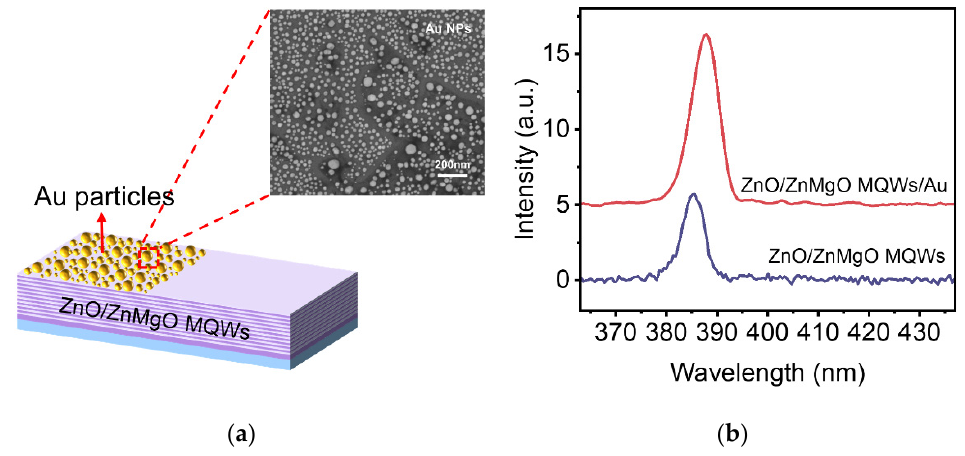
Figure 5. The Schematic and MPA upconversion PL spectra of ZnO/ZnMgO MQWs/Au NPs. ( a ) Schematic of ZnO/ZnMgO MQWs/Au NPs composite. Inset, the SEM image of Au NPs on ZnO/ZnMgO MQWs. ( b ) The MPA upconversion PL spectra of dominant emission peaks in the ZnO/ZnMgO MQWs covered with and without Au NPs.